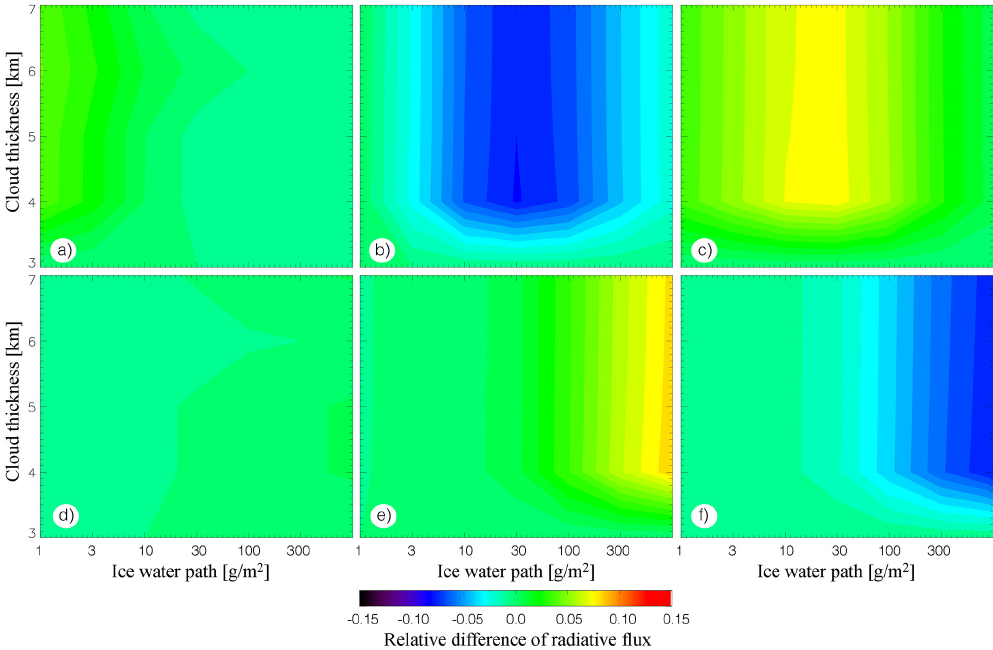
Figure 9. The relative difference in SW fluxes with respect to rectangular IWC( z ) profile type estimated for 3 to 7km thick clouds with average De = 50µm and with a cloud top at 15km. (a – c) TOA; (d – f) : SRF; (a, d) isosceles trapezoid; (b, e) lower triangles; (c, f) upper